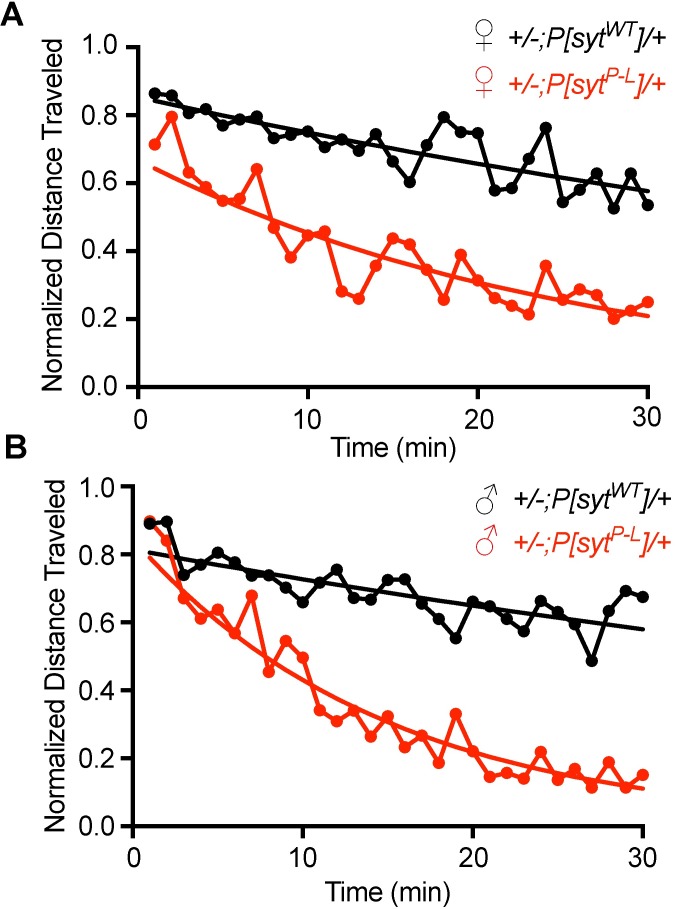
The sytP-L mutation increases the rate of fatigue in Drosophila.(A, B) Normalized values of distance traveled up a vial wall after repetitive drops over time for 5–7 day old females (A) and males (B). Each point is a binned 1 minute average of 6 drops (1 drop every 10 seconds) normalized to the percentage of the distance traveled after the first drop. Statistical analysis indicates different rates of fatigue (see methods) between the two genotypes for both females (p < 0.0001) and males (p < 0.0001), indicating the P[sytP-L] heterozygotes (n = 10) fatigued significantly faster than controls (n = 10).